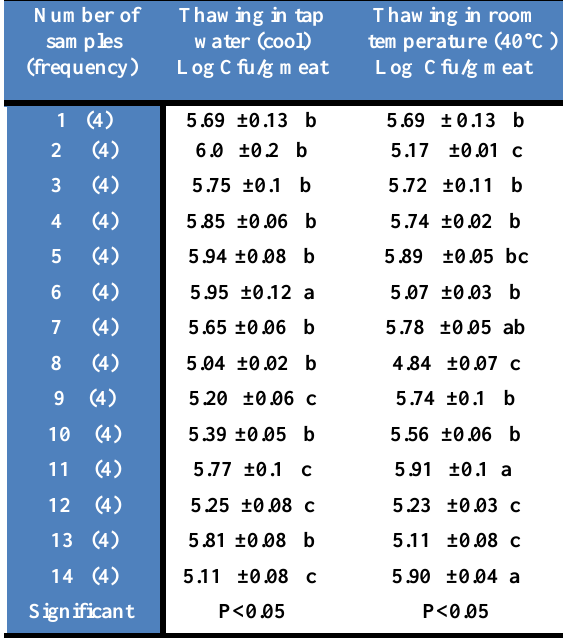
Table, 1: The mean values of total bacterial count in minced meat samples after thawing in tap water and room